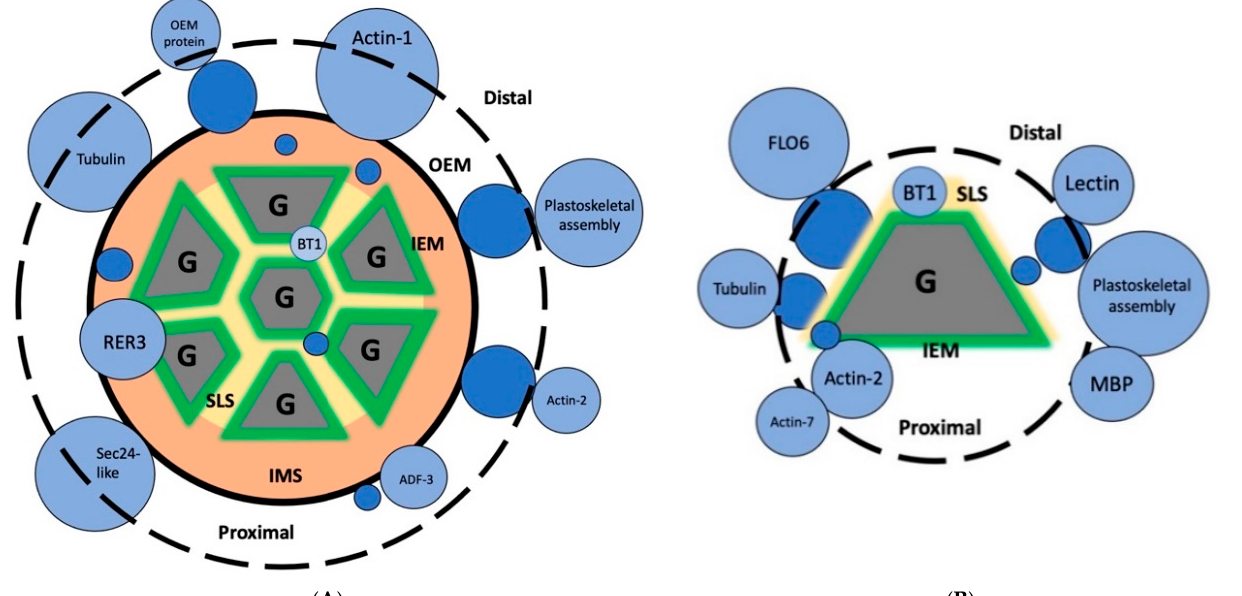
Figure 3. Distal proteomes and proximal amylomes of the rice starch granule represented as schematic sets. ( A ) An intact starch grain. ( B ) An isolated starch granule (G). ADF, actin-depolymerizing factor. BT1, Brittle-1. IEM, inner envelope membrane (green). IMS, intermembrane space (orange). MBP, microtubule-binding protein. OEM, outer envelope membrane (black). RER, reticulata-related. SLS, septum-like structure (yellow). Known and hypothetical starch grain framework proteins are in blue [4–6]. Proteins not drawn to scale.